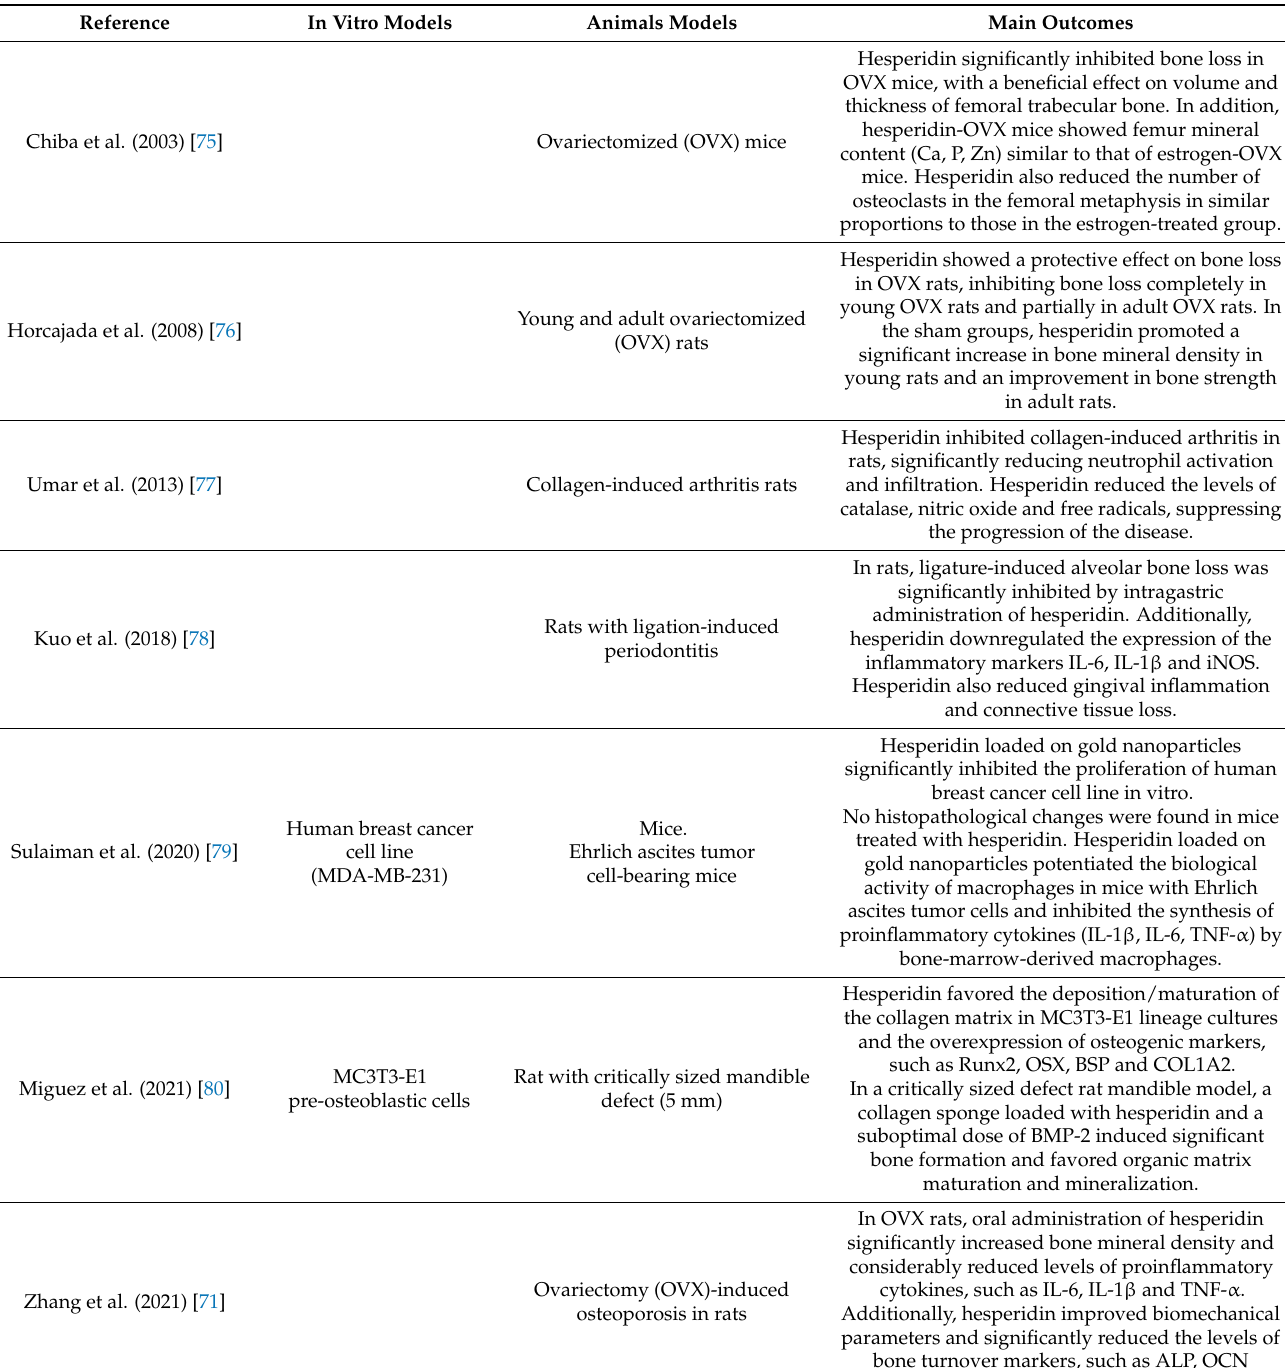
Table 2. In vitro and in vivo studies that evaluated the osteoprotective and anti-inflammatory effects of